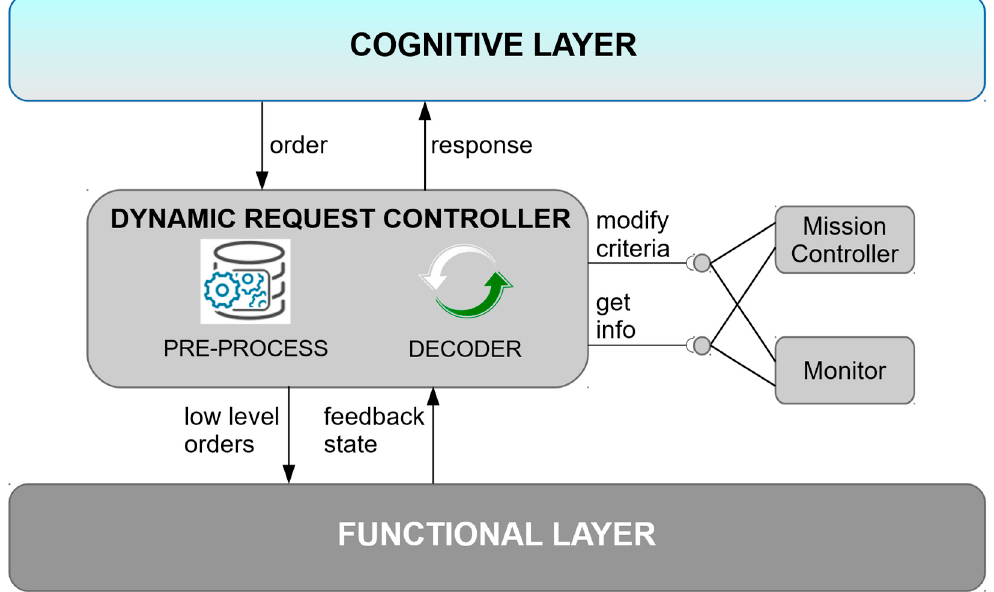
Figure 5. Dynamic Request Controller component (operative layer).